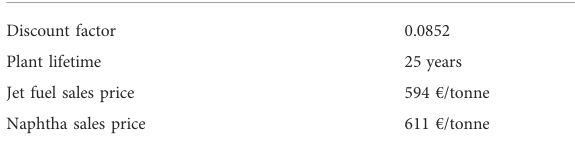
TABLE 7 List of assumptions for the NPV calculation (Jet-A1-Fuel, 2021; Damodaran, 2019; Börse,